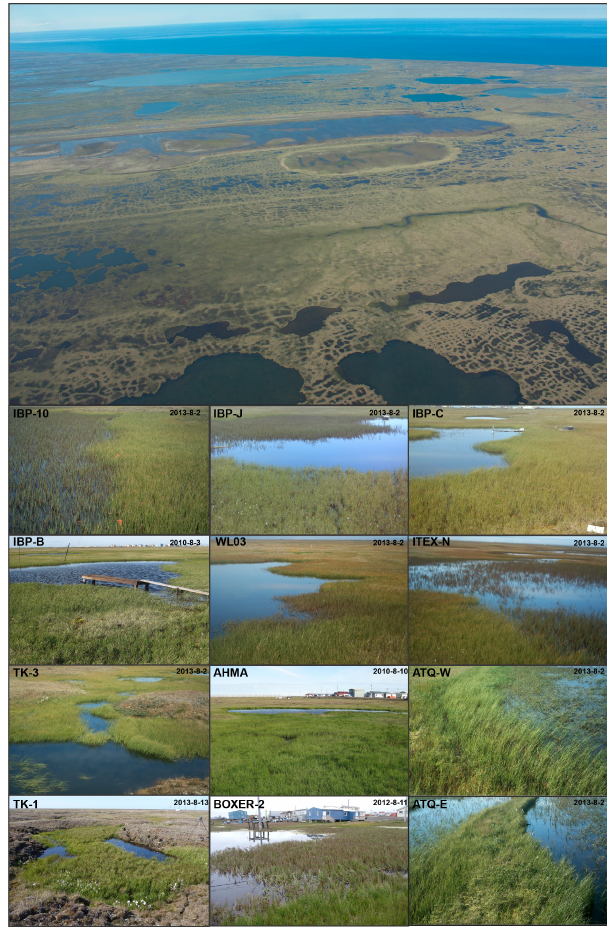
Figure 2. Aerial view the Arctic coastal plain near Utqia˙gvik, AK, and examples of sites sampled in this study. Images indicate site name (top left) and picture date YYYY/M/D (top right). Photos by Christian G.